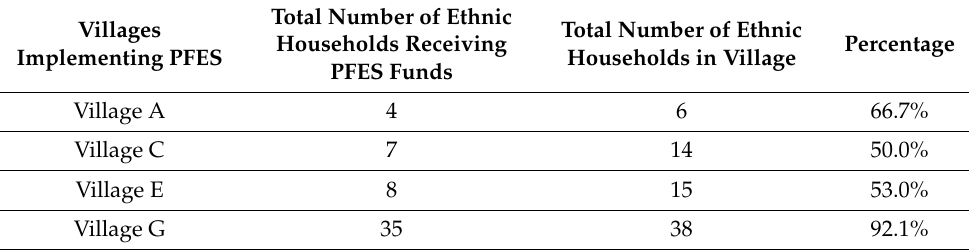
Table 4. Ethnic minority households receiving PFES funds in